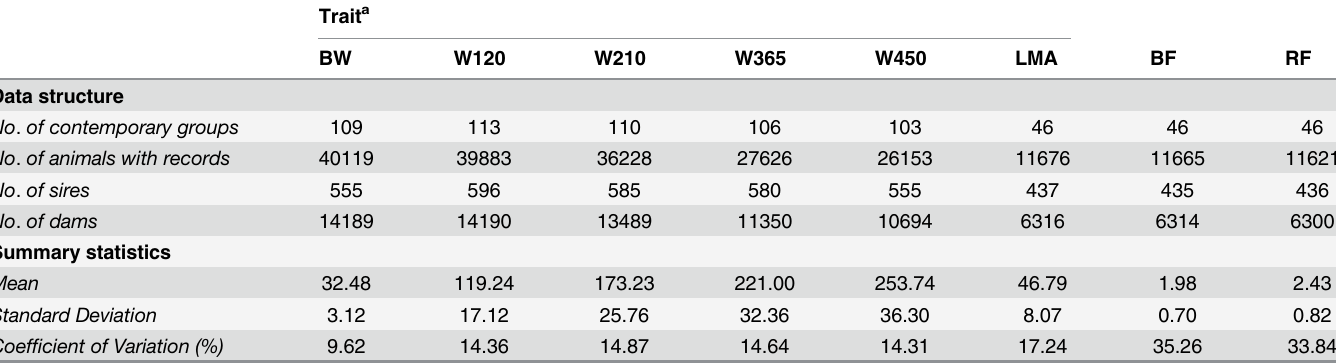
Table 1. Description of the final data set of carcass traits as measured by ultrasound of the live animal, and growth traits in Polled Nelore cattle. Trait